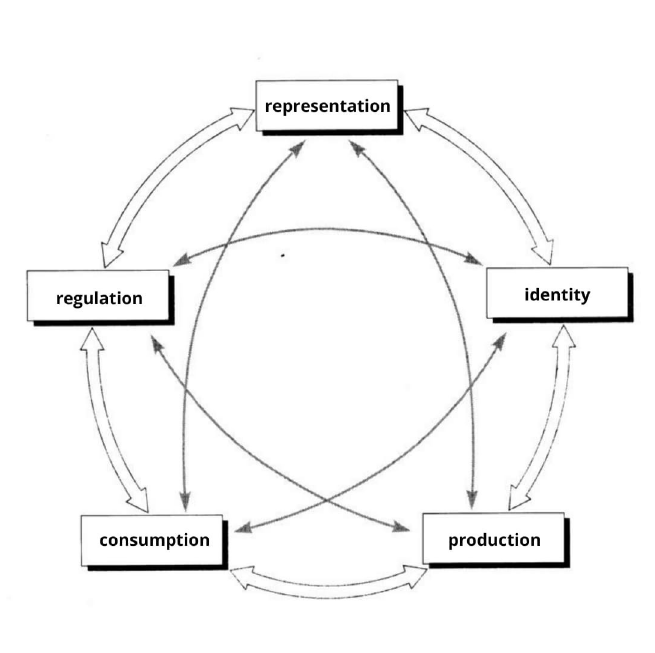
Fig. 2. The circuit of culture (Du Gay et Al ., 1997 and